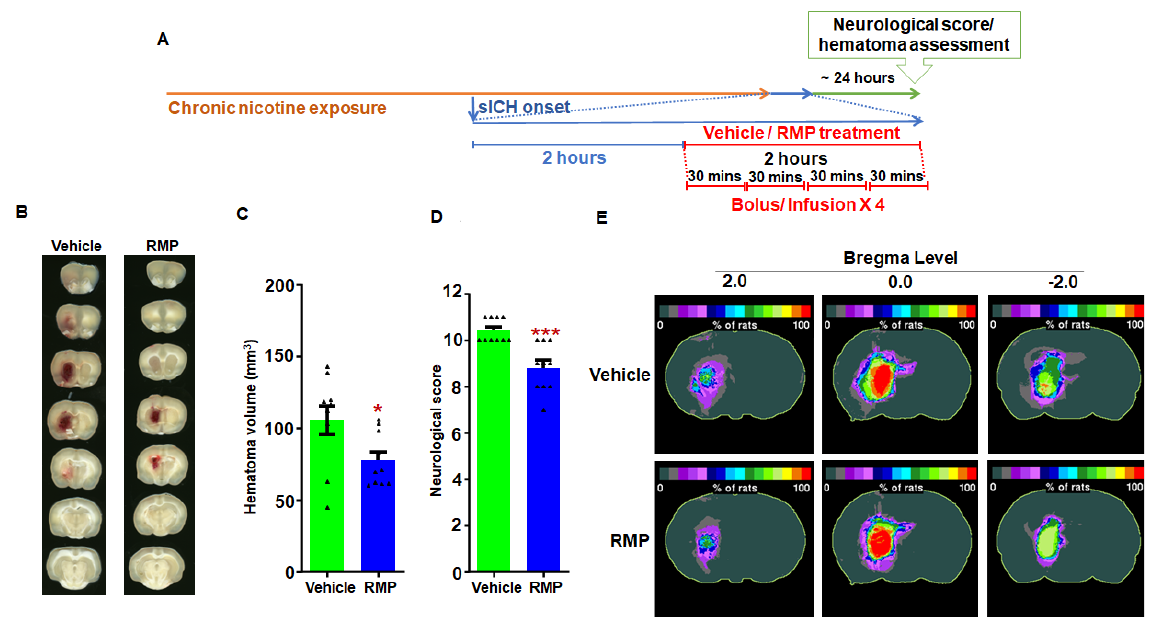
Figure 1. The effect of RMP treatment on hematoma expansion post-sICH in nicotine-exposed male rats: ( A ) representation of experimental design; ( B ) example images of brain scans showing mean hematoma volume; ( C ) mean hematoma volume data; ( D ) mean neurological score data; and ( E ) hematoma frequency maps at 3 coronal levels (bregma +2.0 mm, 0.0, and − 2.0 mm). The top row depicts the hematoma frequency maps of vehicle-treated rats, and the bottom row shows the hematoma frequency maps of RMP-treated rats. N = 10 for vehicle- and RMP-treated groups, respectively; * p < 0.05 and *** p < 0.001 vs. vehicle